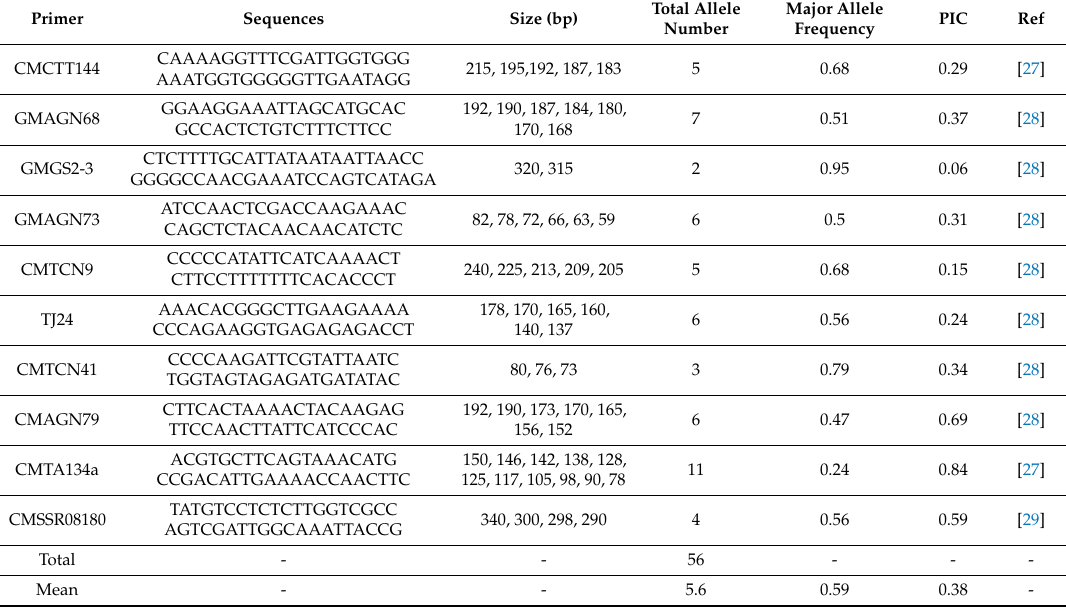
Table 5. Genetic variability parameters recorded for each simple sequence repeat (SSR) marker used in this